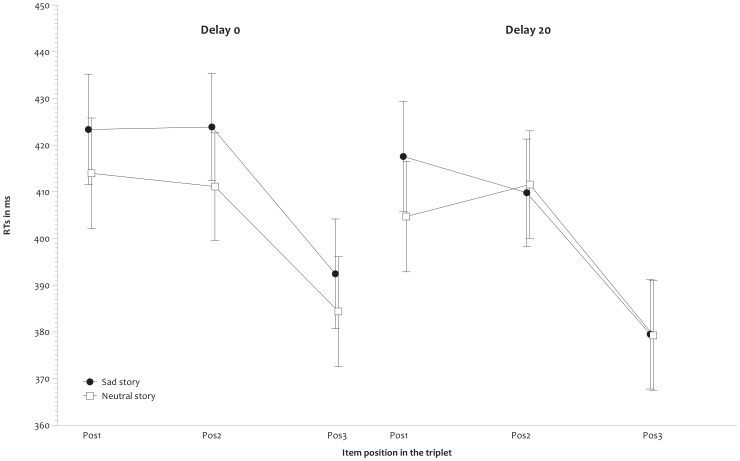
RTs in the RSVP task.Mean detection latencies for the three positions (Pos1, Pos2, Pos3) in the RSVP task, plotted separately for the neutral and sad mood groups, and by Delay condition.